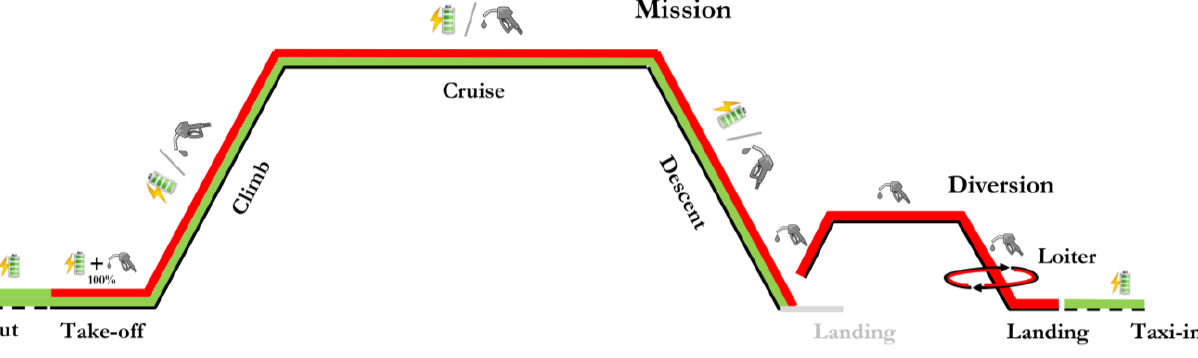
Figure 7. Mission profile with a scheme of the selected power supply strategy.